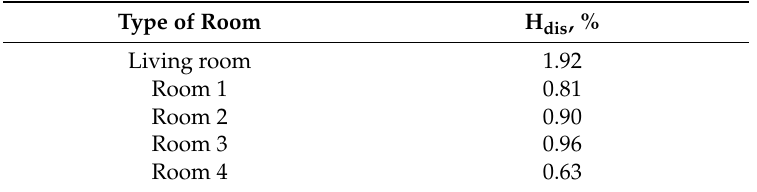
Table 2. H dis in case